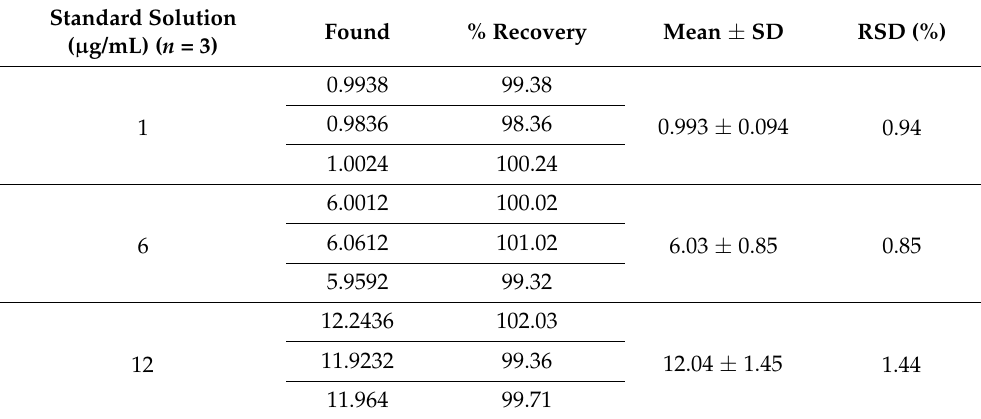
Table 2. Accuracy results for fasudil in the standard